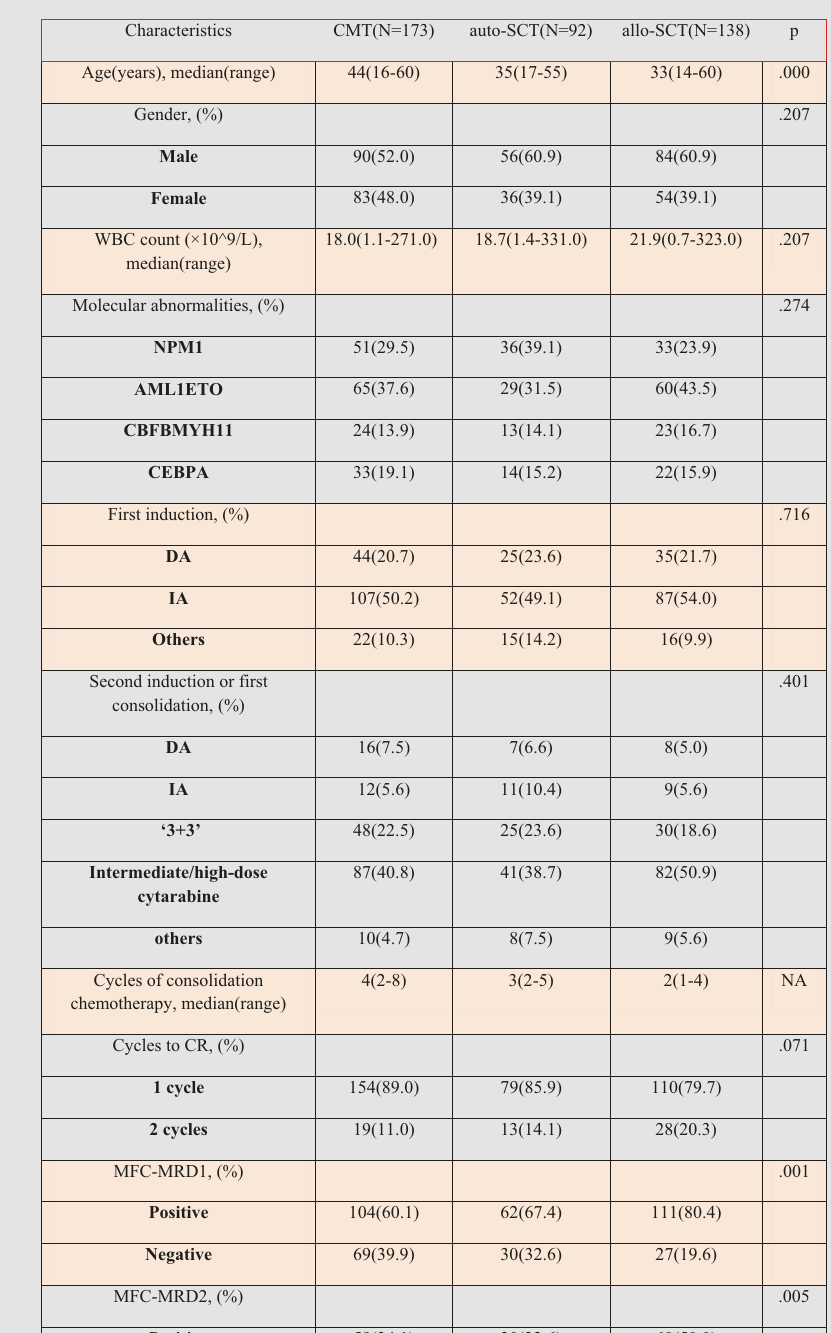
Table 1. The demographics and treatment characteristics of